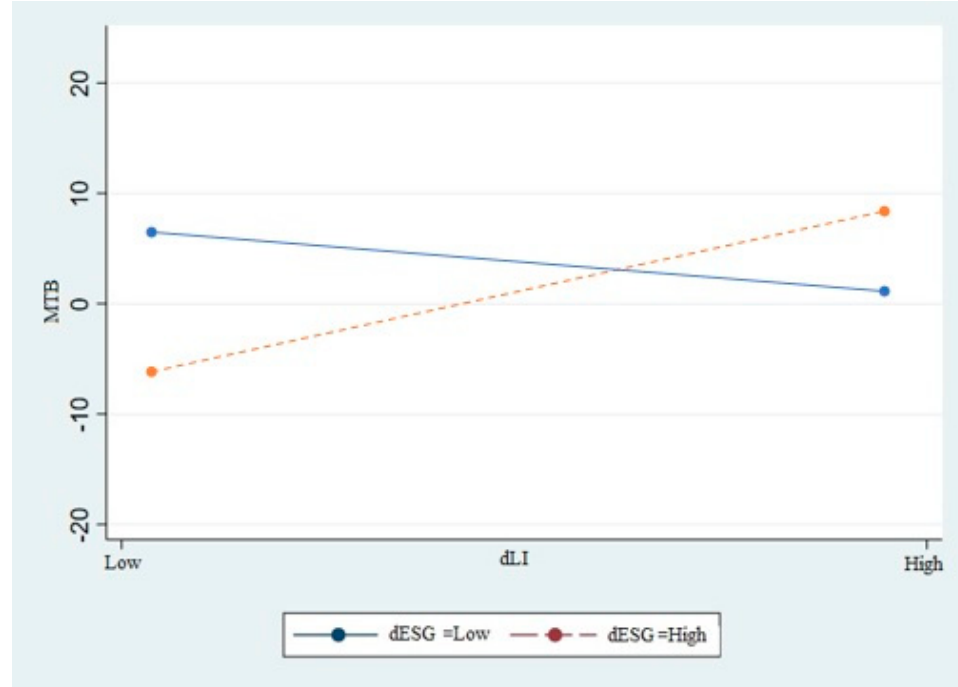
Figure 2. Interaction Graph.